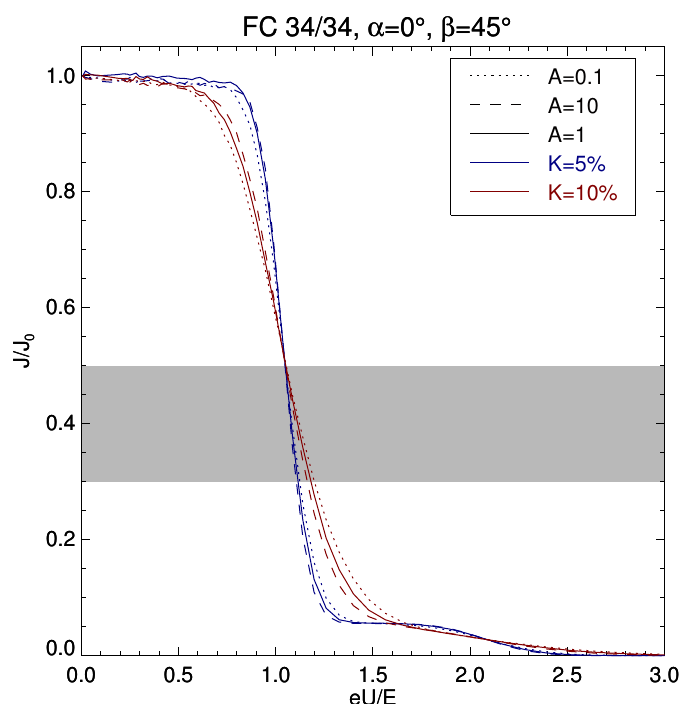
Figure 4. FC energetic characteristics–normalized FC current, J / J 0 as a function of the normalized grid potential, eU / E for the incidence angle, α = 0 ◦ and the angle between the IMF and z-axis, β = 45 ◦